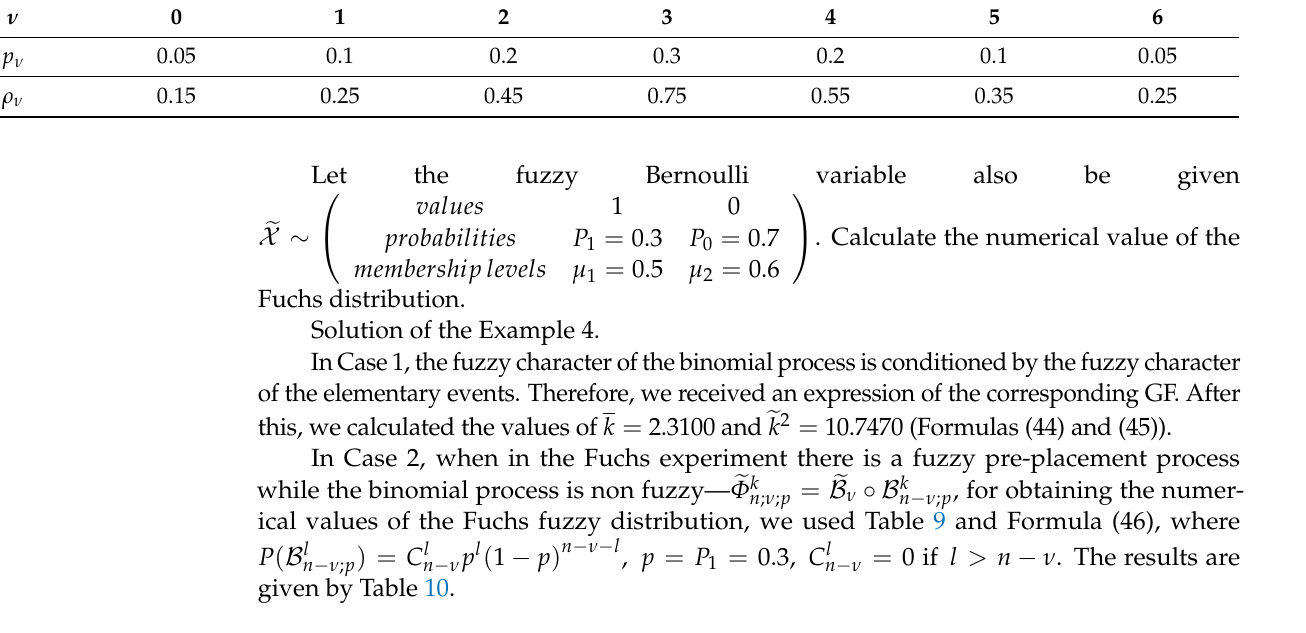
Table 10. Values of the Fuchs fuzzy